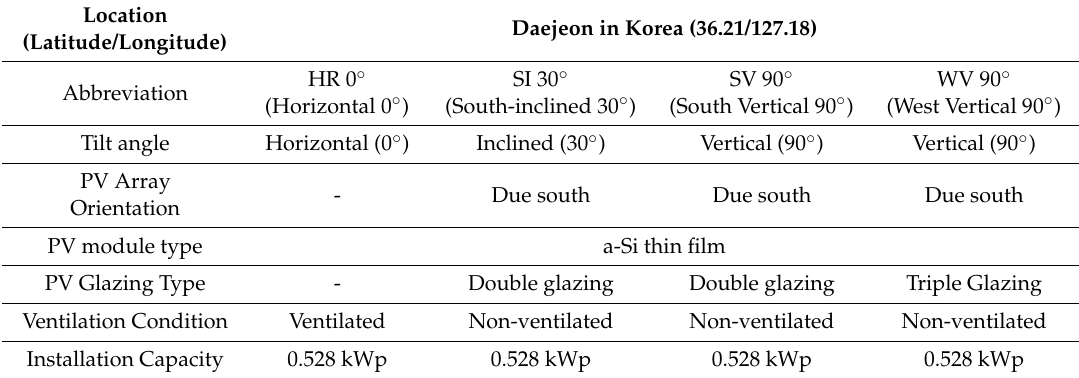
Table 1. Description of the building-integrated photovoltaics (BIPV) window system.